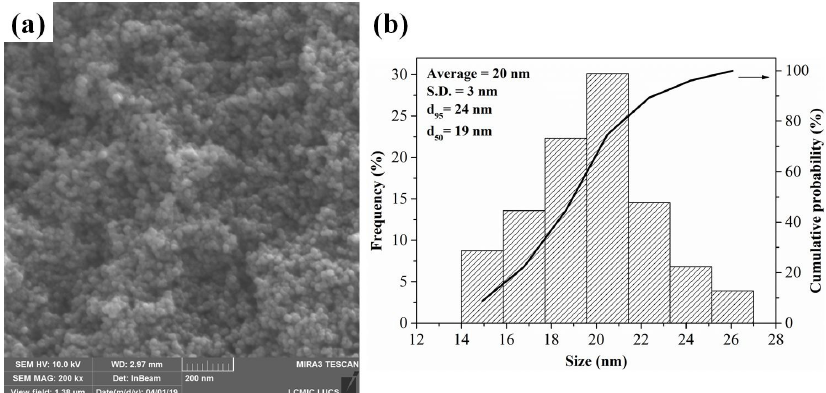
Figure 6. (a) Analysis by FESEM and (b) particles distribution for ZnO sample.